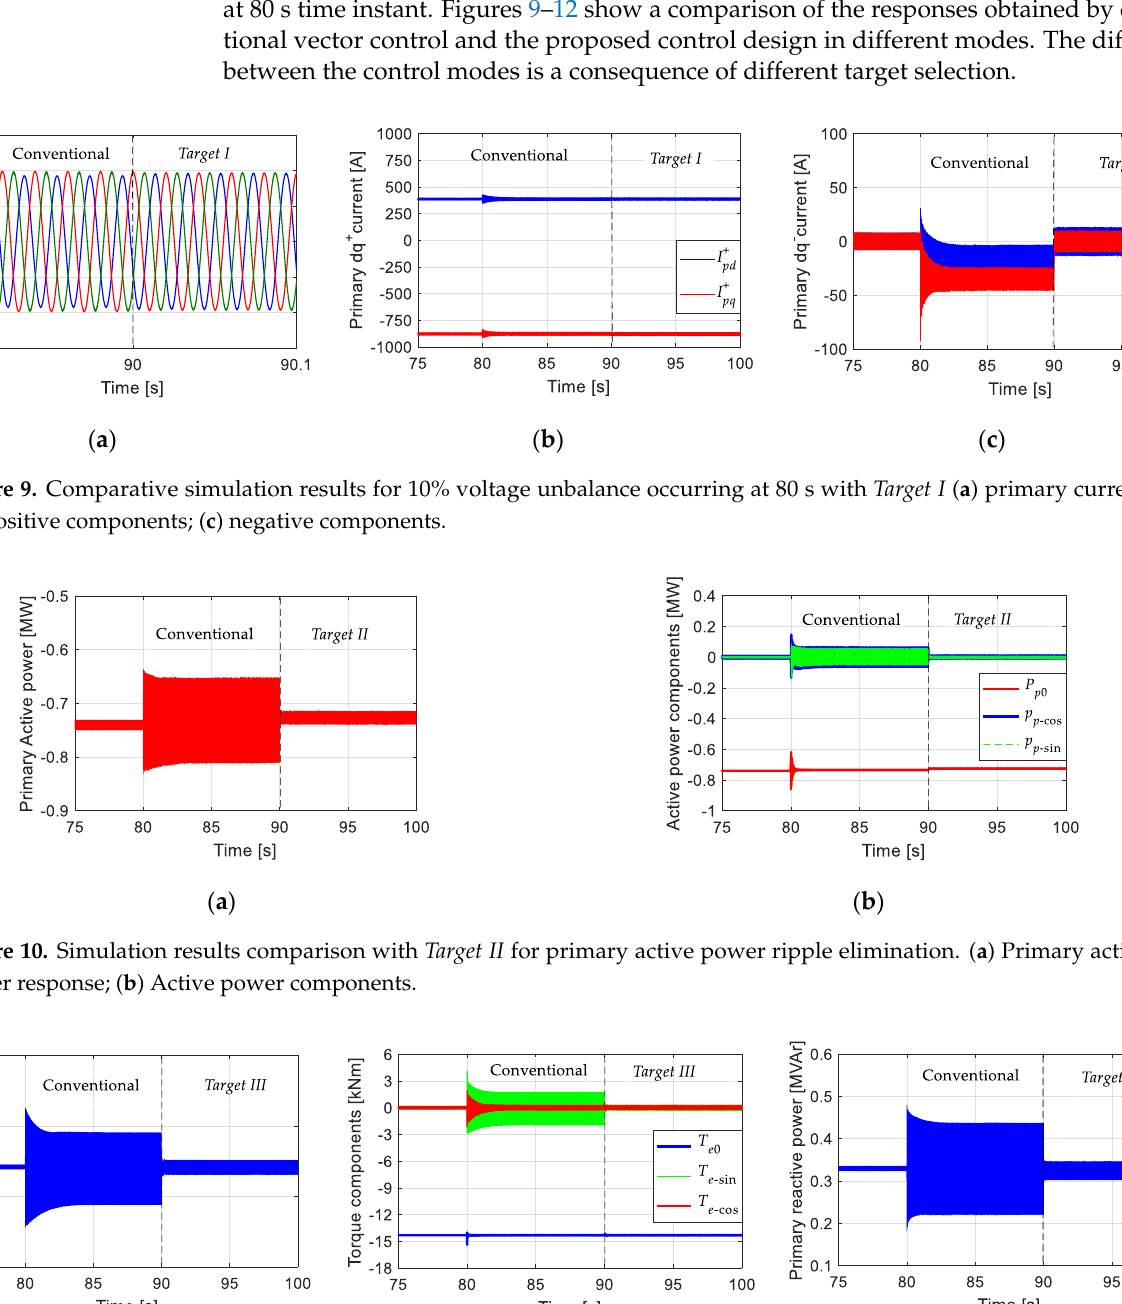
Figure 11. Simulation results comparison with Target III for torque and reactive power ripple elimination. ( a ) Torque response; ( b ) torque components; ( c ) primary reactive